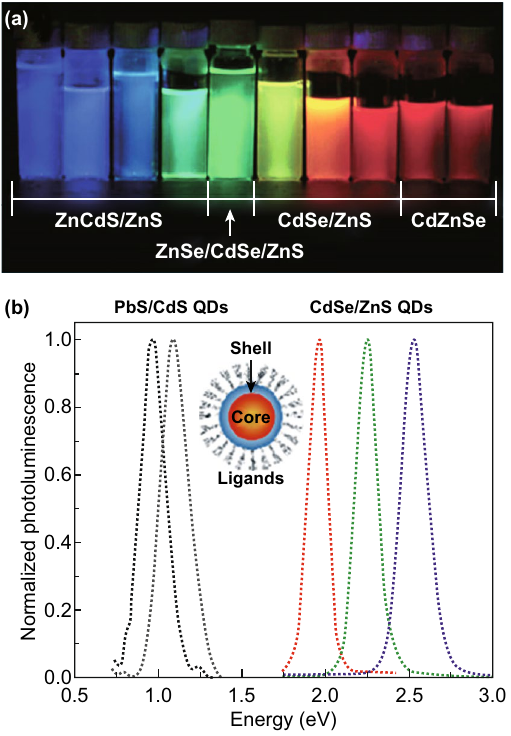
Fig. 9 a Photograph of PL of core@shell QDs with different com‑ positions. In this photograph, QD solutions are excited by a UV lamp with emission centered at a wavelength of 365 nm. Reproduced with permission from Ref. [161]. Copyright 2009, American Chemi‑ cal Society. b PL spectra of CdSe@ZnS and PbS@CdS core@shell QDs showing the possibility for narrowband emission across the vis‑ ible and near‑IR wavelength regions. Inset: schematic illustration of a core@shell QD. Reproduced with permission from Ref. [160]. Copy‑ right 2010, Nano